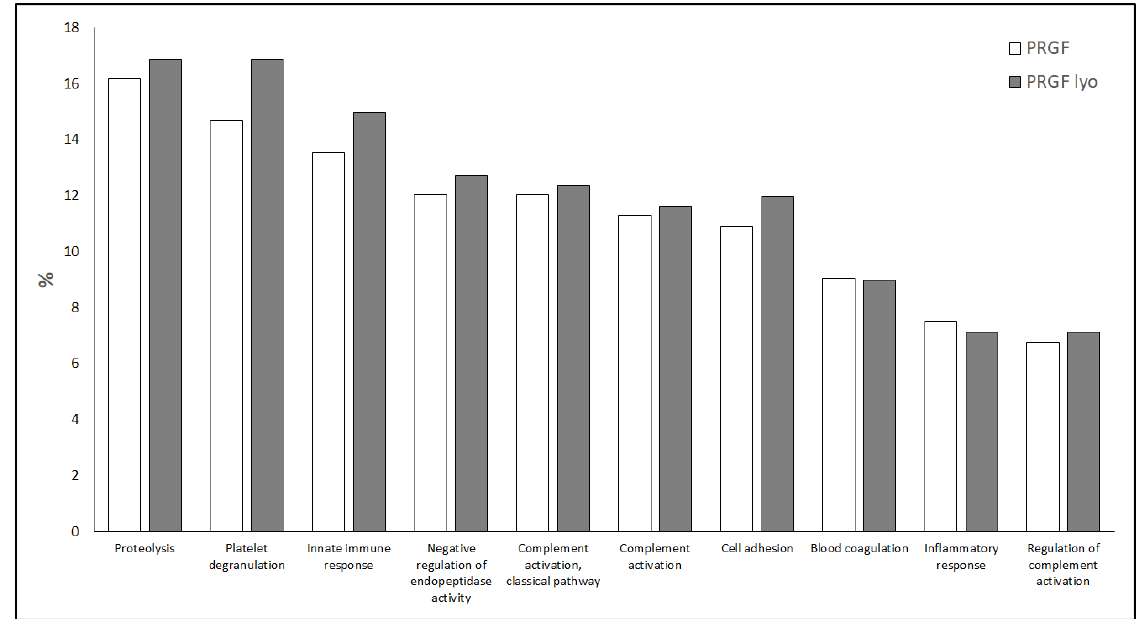
Figure 3. The ten most abundant Gene Ontology terms identified in PRGF and PRGF lyo formulations.